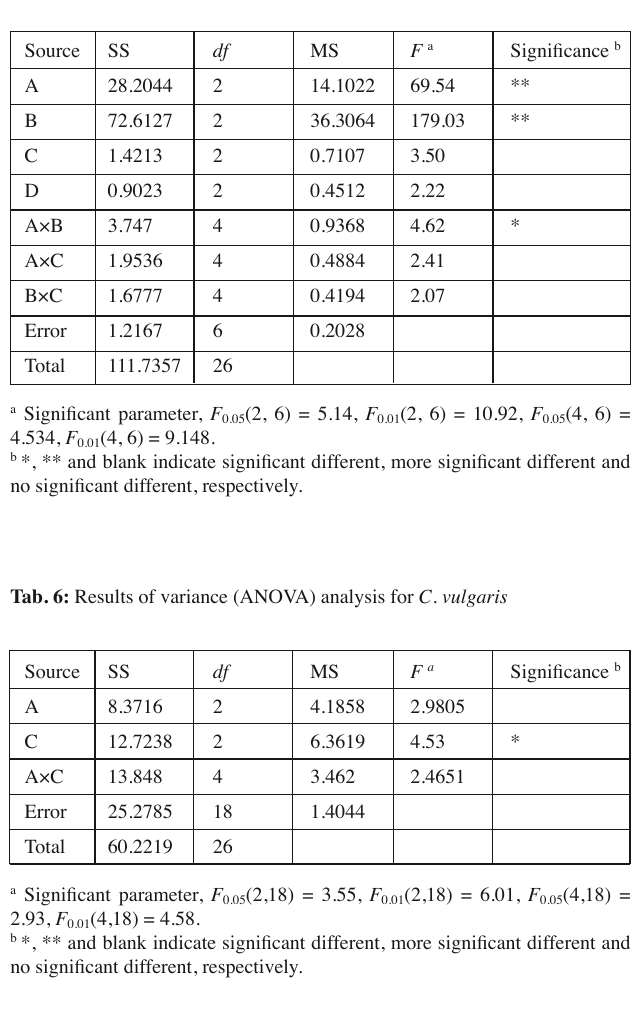
Tab. 5: Results of variance (ANOVA) analysis for N . obtuse